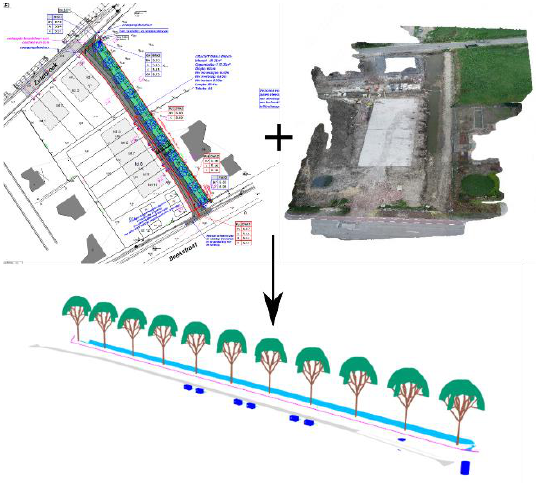
Figure 4. The creation of the EP BIM from different 2D plans and a georeferenced output from an exploring flight.